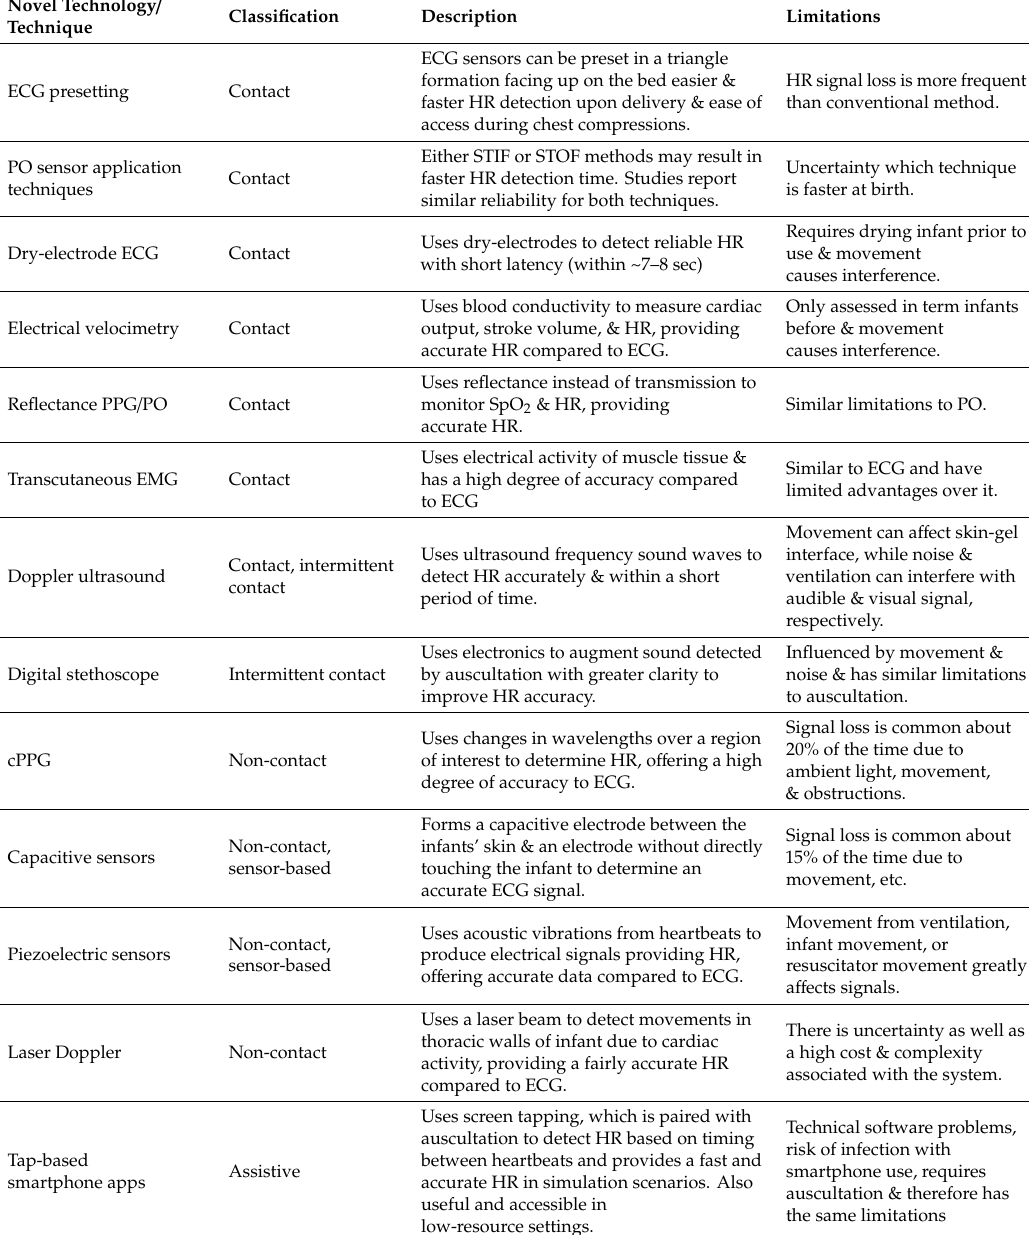
Table 2. Novel technologies or techniques for heart rate assessment identified in this review and three systematic reviews [15,41,54]. Each technology is characterized according to its classification, functionalities and strengths, and limitations. Abbreviations: HR: heart rate; ECG: